Question: What type of chart is this?
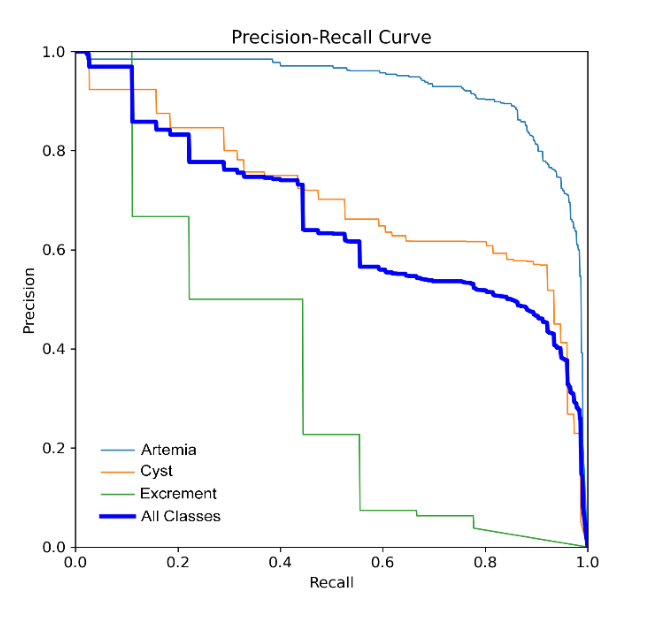
Answer: line